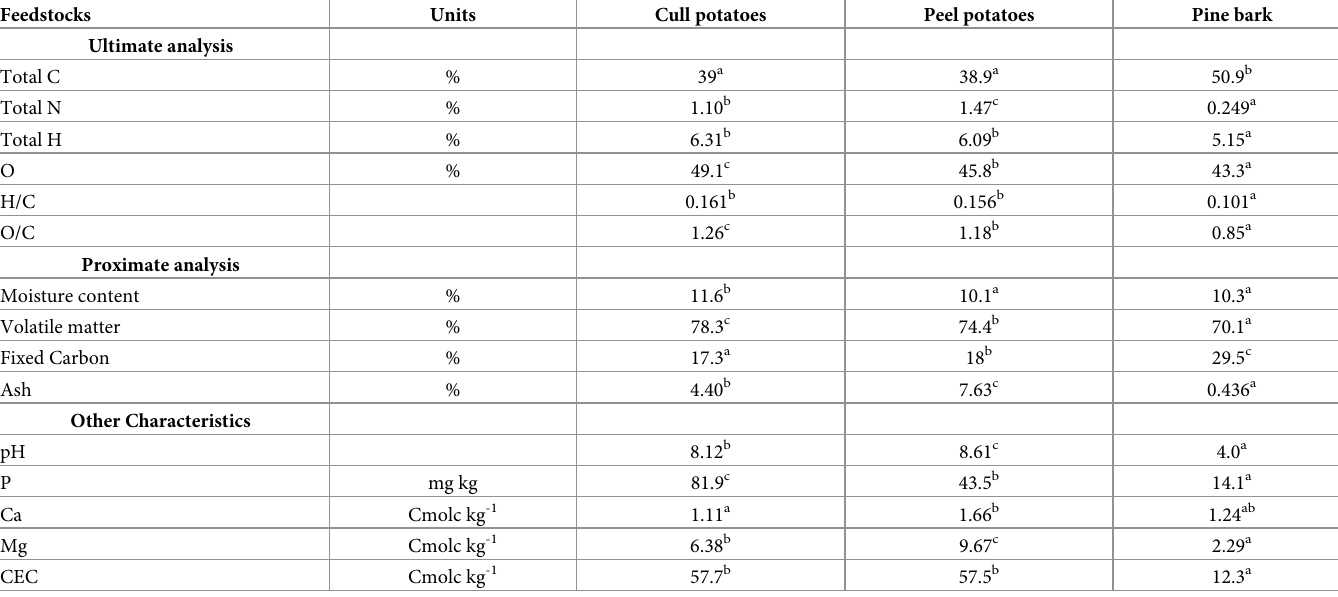
Table 1. Characteristics of raw